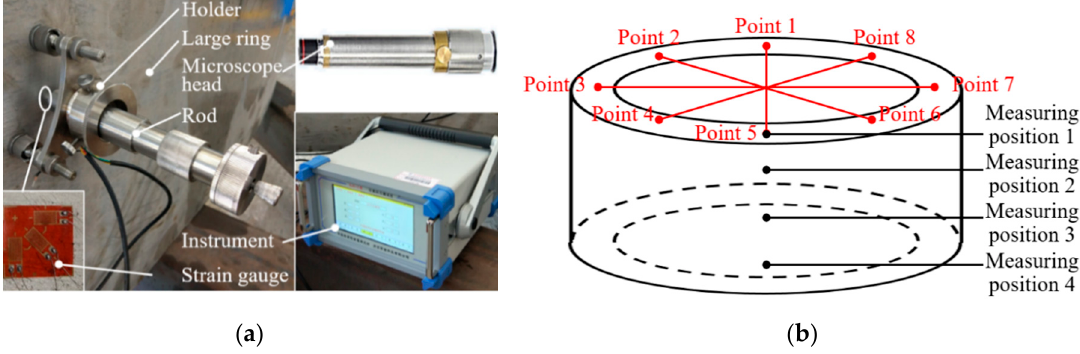
Figure 2. ( a ) Residual ‐ stress measurement experiment; ( b ) measurement points.